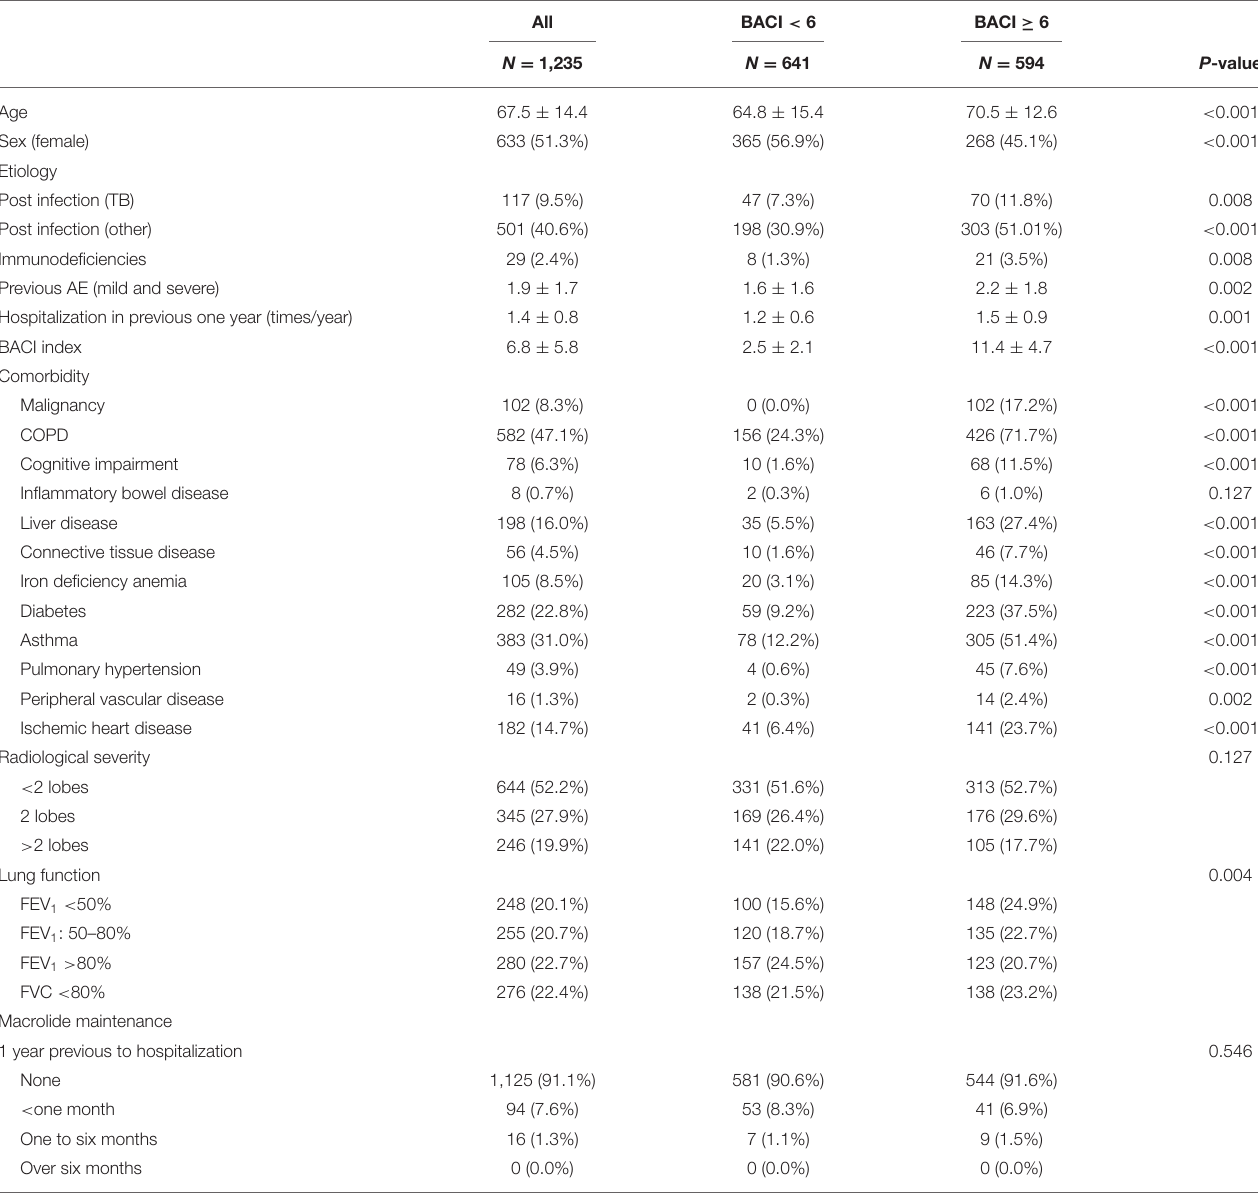
TABLE 1 | Baseline